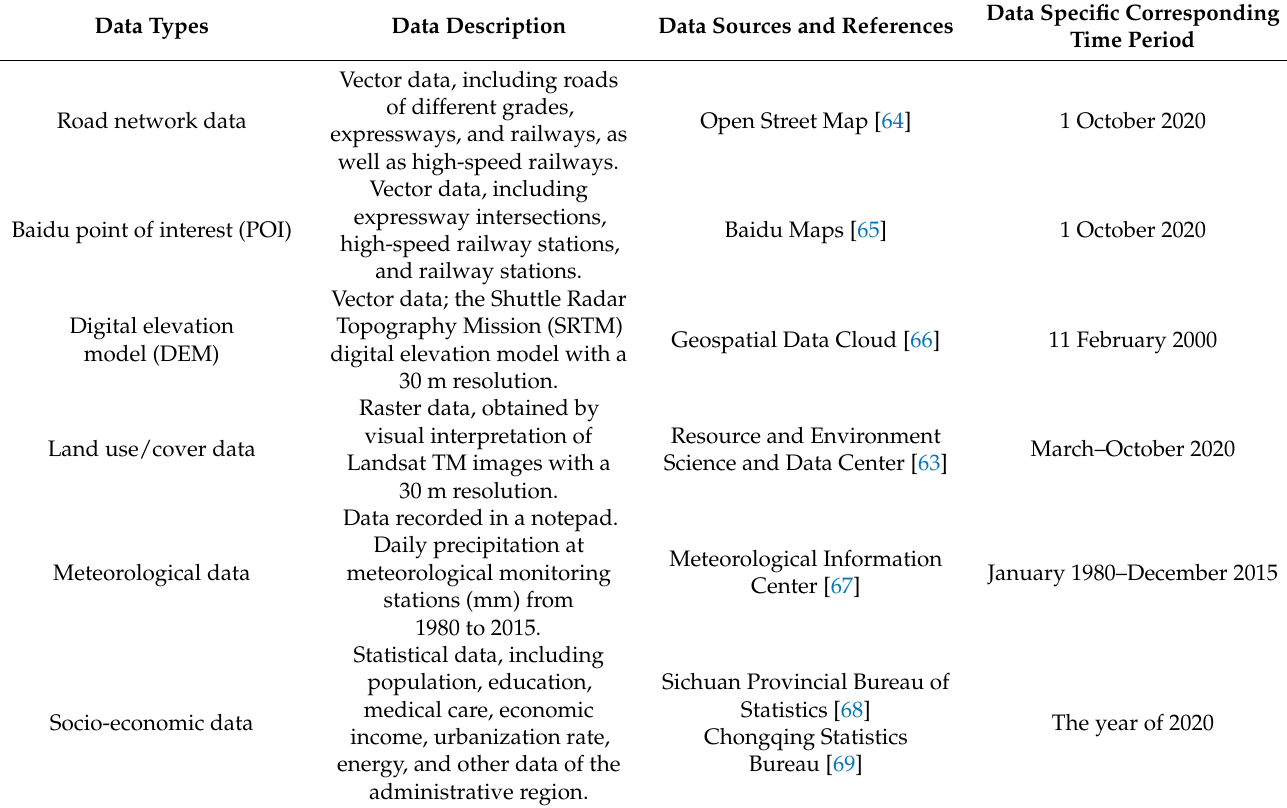
Table 1. Description of the data used for this